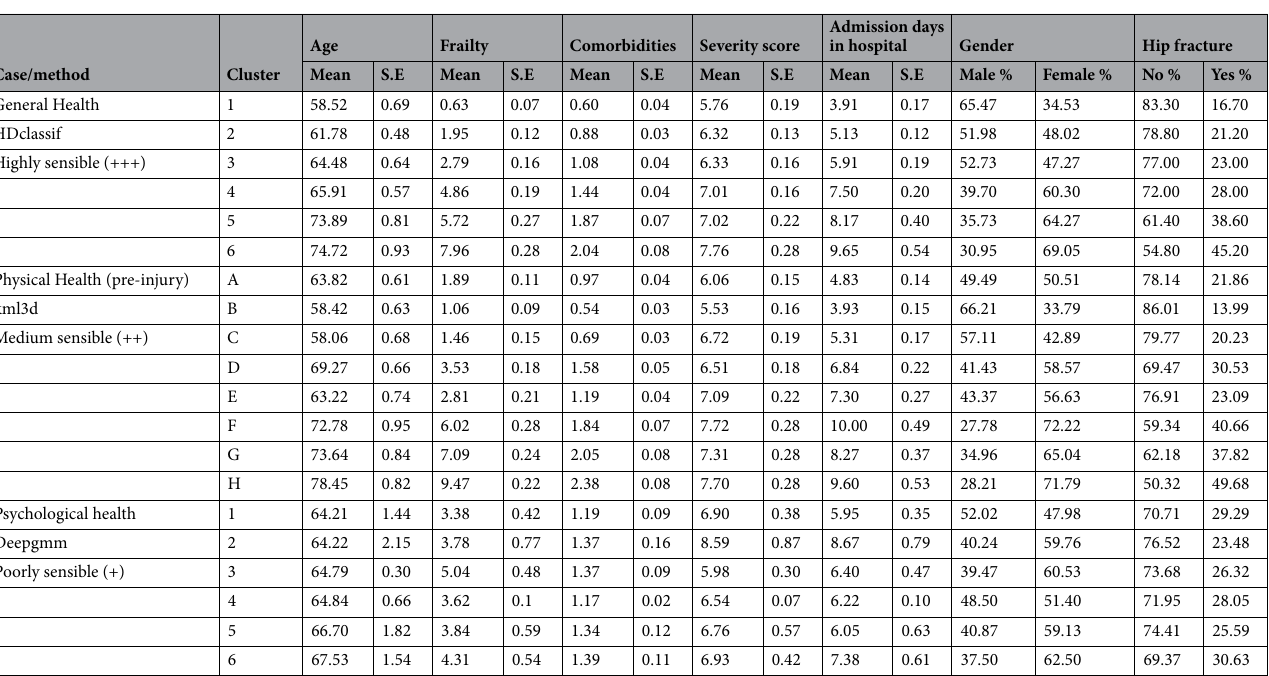
Table 5. Descriptive statistics for clusters obtained with different methods and that have been evaluated as Highly (+++), Medium (+ +) and Poorly ( +)